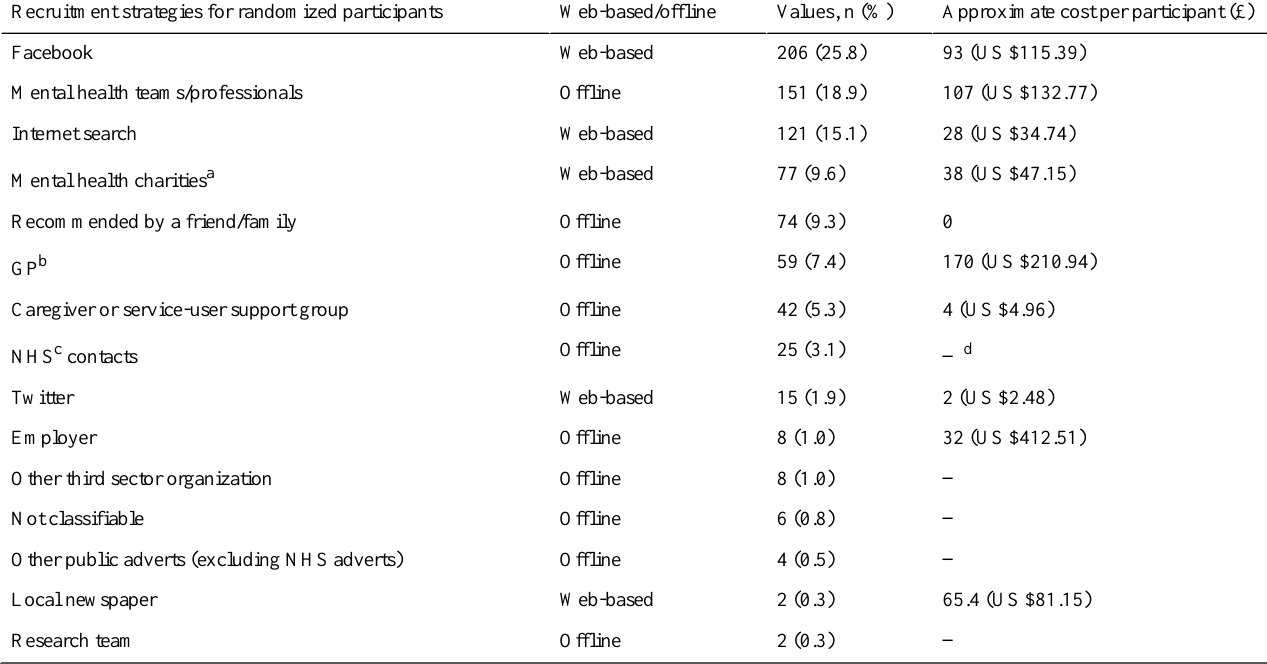
Table 1. Recruitment strategies for randomized participants.